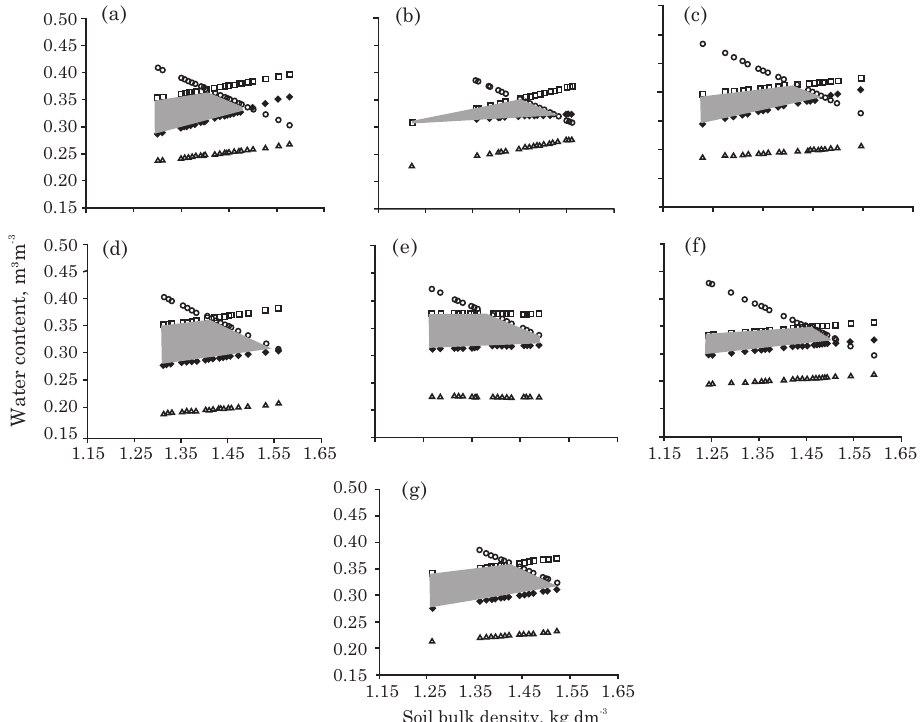
Figure 5. Least limiting water range under winter crops [(a) corn, (b) sunflower, (c) oilseed radish, (d) pearl millet, (e) pigeon pea, (f) grain sorghum, and (g) sunn hemp] within soybean/soybean in summer in which o = air-filled porosity, ooooo = field capacity, = soil resistance to penetration, and ∆∆∆∆∆ = air-filled